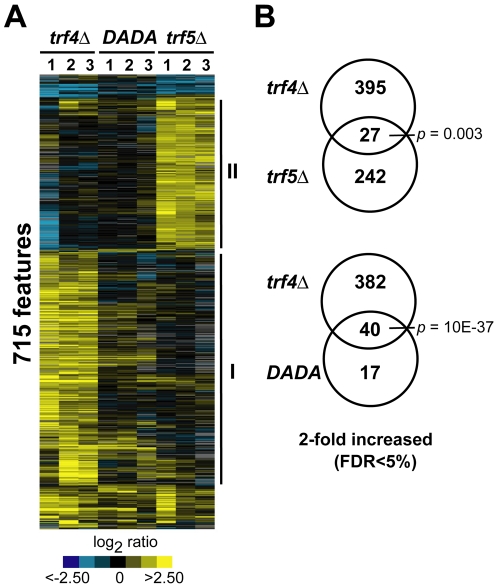
Features with altered levels in trf4Δ, trf5Δ, and polyadenylation-defective trf4Δ/TRF4-DADA mutants.(A) Hierarchical cluster of 715 features that changed at least 2-fold (FDRs<5%) in trf4Δ, trf5Δ, or trf4Δ/TRF4-DADA mutant cells (Table S1). Columns (1, 2, 3) correspond to individual experiments, rows to genes. The RNA levels in the trf4Δ or trf5Δ mutant strain relative to the WT (BY4741) strain, and in the trf4Δ/TRF4-DADA (DADA) mutant strain relative to BY4741/pNOPPATA1L strain, are colored in the yellow-blue ratio scale as indicated at the bottom. Yellow shades indicate higher transcript abundance in mutants compared to WT, and blue shades represent lower transcript abundance. Grey represents missing values. Solid lines (I and II) mark the 422 and the 269 features that were selectively increased in the trf4Δ (I) or the trf5Δ (II) mutants, respectively. (B) Venn diagrams representing overlap of transcripts that were at least 2-fold increased in mutants compared to WT. P-values relate to the significance of the overlap (Fisher's Exact test, right tail).